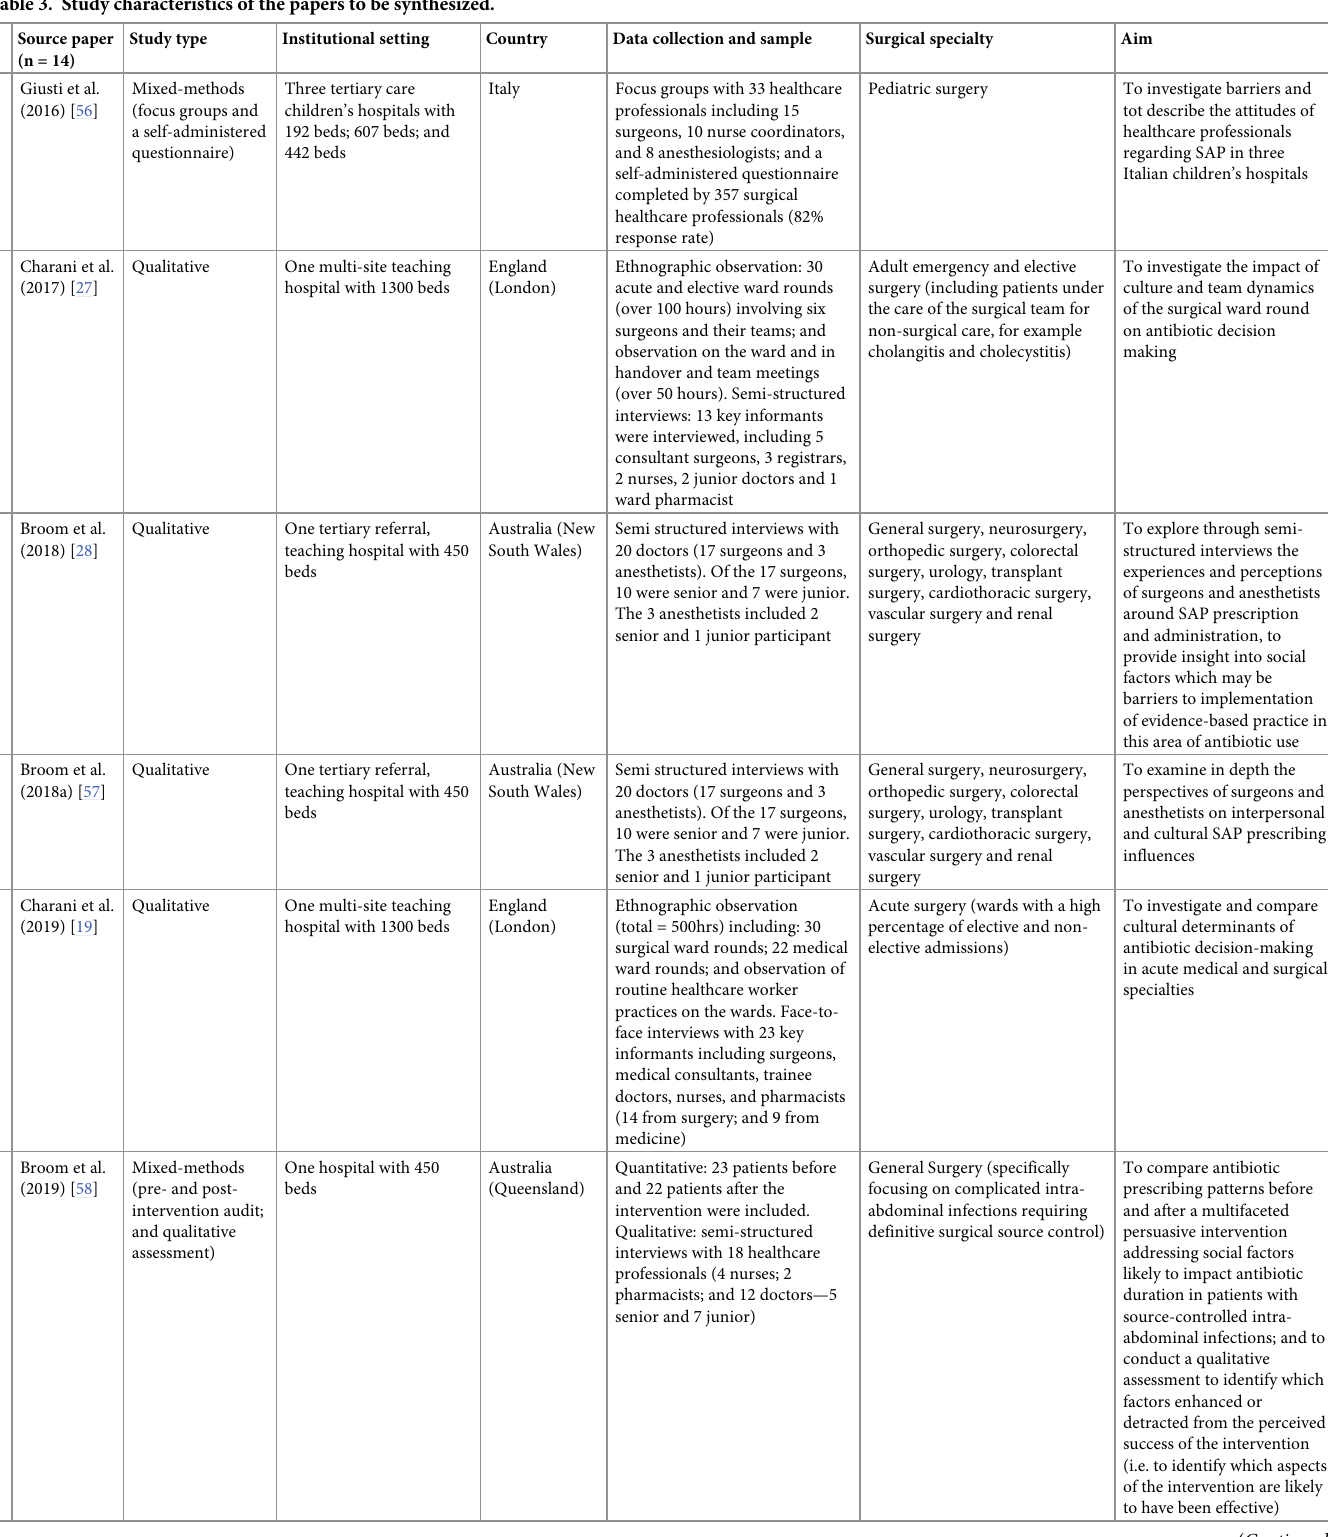
Table 3. Study characteristics of the papers to be